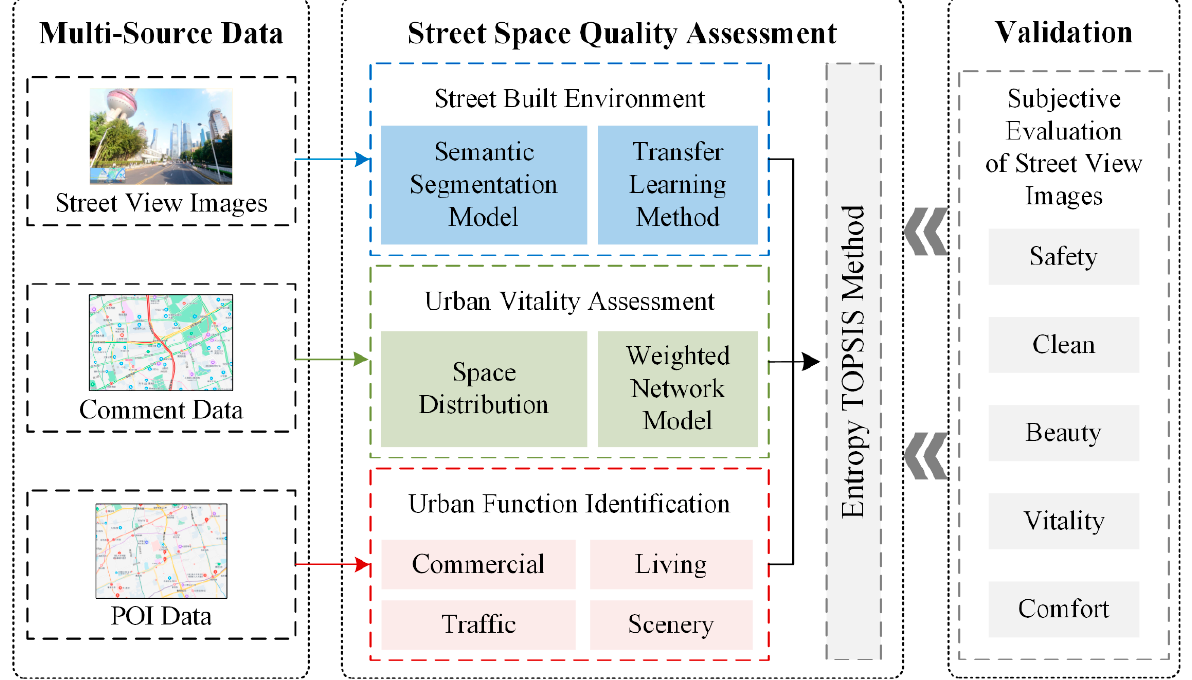
Figure 4. Workflow chart of the methodology proposed in this study.